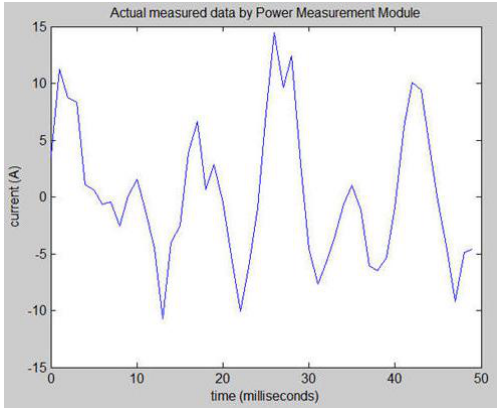
Figure 44. Actual measured data in millisecond units using the Power Measurement Module.